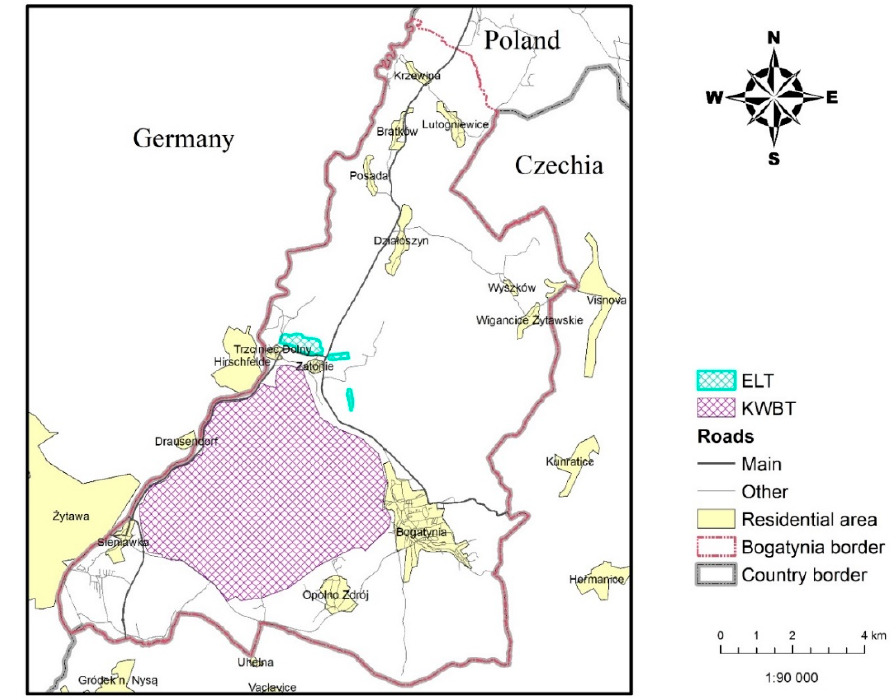
Figure 2. The analyzed area (source: own study ).